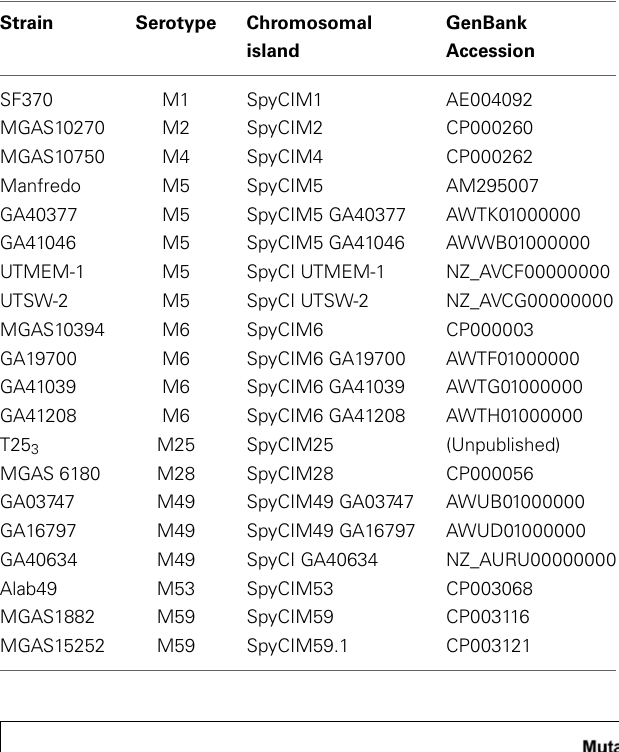
Table 1 | S. pyogenes strains with SpyCI integrated into DNA MMR gene mutL that have been identified by genome sequencing.